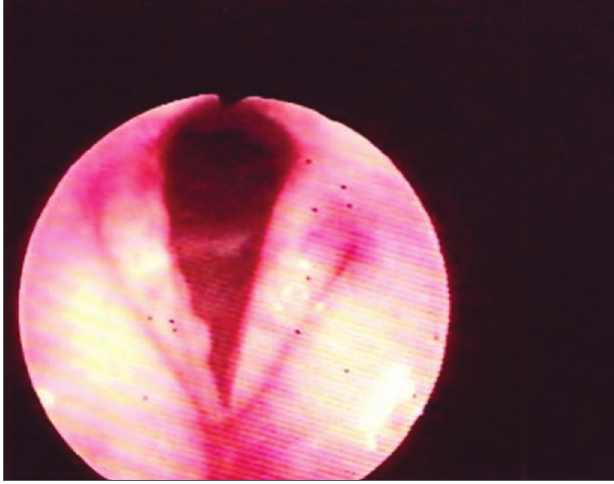
Figura 4. Espessamento com hiperemia de pregas vocais com irre- gularidade em borda livre.